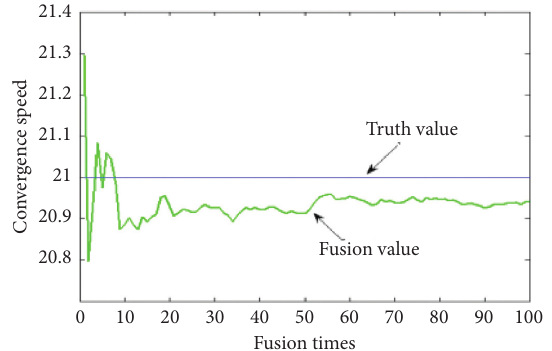
Figure 6: Fusion effect of the algorithm before improvement.